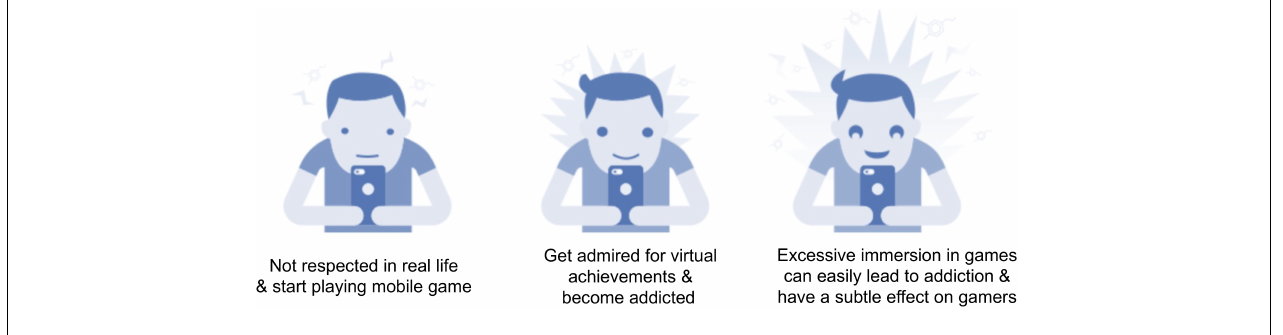
FIGURE 4 | Addiction progress of mobile games and its different stages.